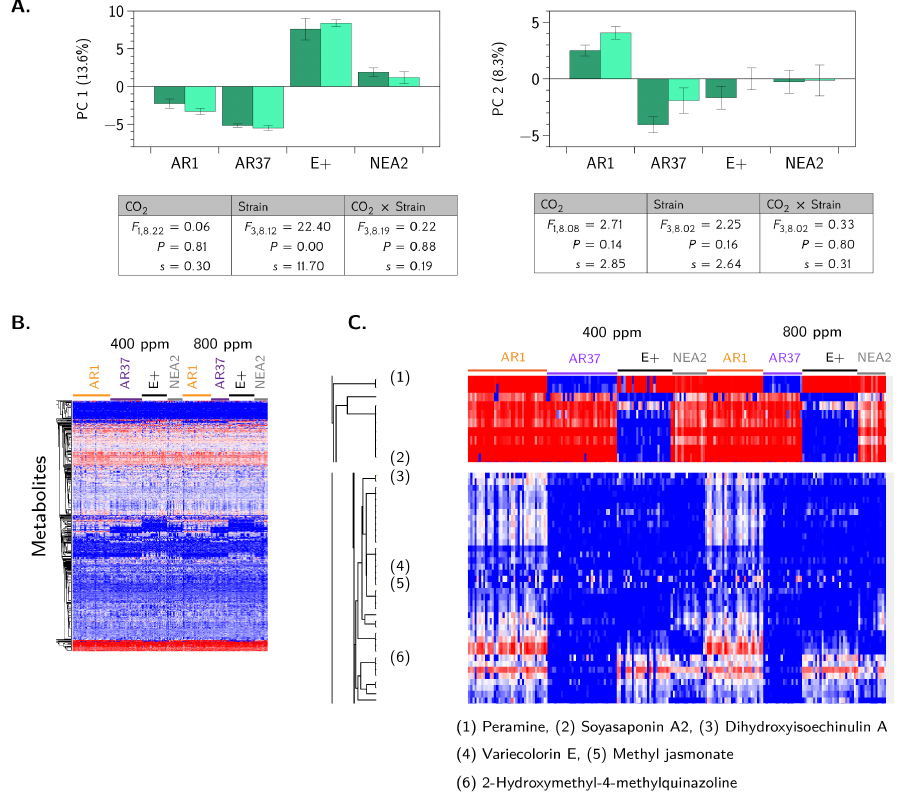
Figure 5. Metabolomic profiling of interaction between L. perenne and epichloid strains. ( A ) Principal component analysis of L. perenne colonized with epichloid strains (e.g., AR1, AR37, E+, NEA2); dark bars denote 400 ppm CO 2 , light bars denote 800 ppm CO 2 . “PC 1” and “PC 2” denote the first and second principal components. The ANOVA tables show the results of a REML analysis for the fixed effects of strain, CO 2 and their interaction; random effects not shown. We also report the Shannon information transformation, s . Bars denote the means and standard errors. ( B ) Heat map of hierarchical clustering by Euclidean distance of all metabolites identified from L. perenne colonized with epichloid strains (e.g., AR1, AR37, E+, NEA2). ( C ) Regions of unique metabolite profiles highlighted and enlarged, along with the available corresponding compound